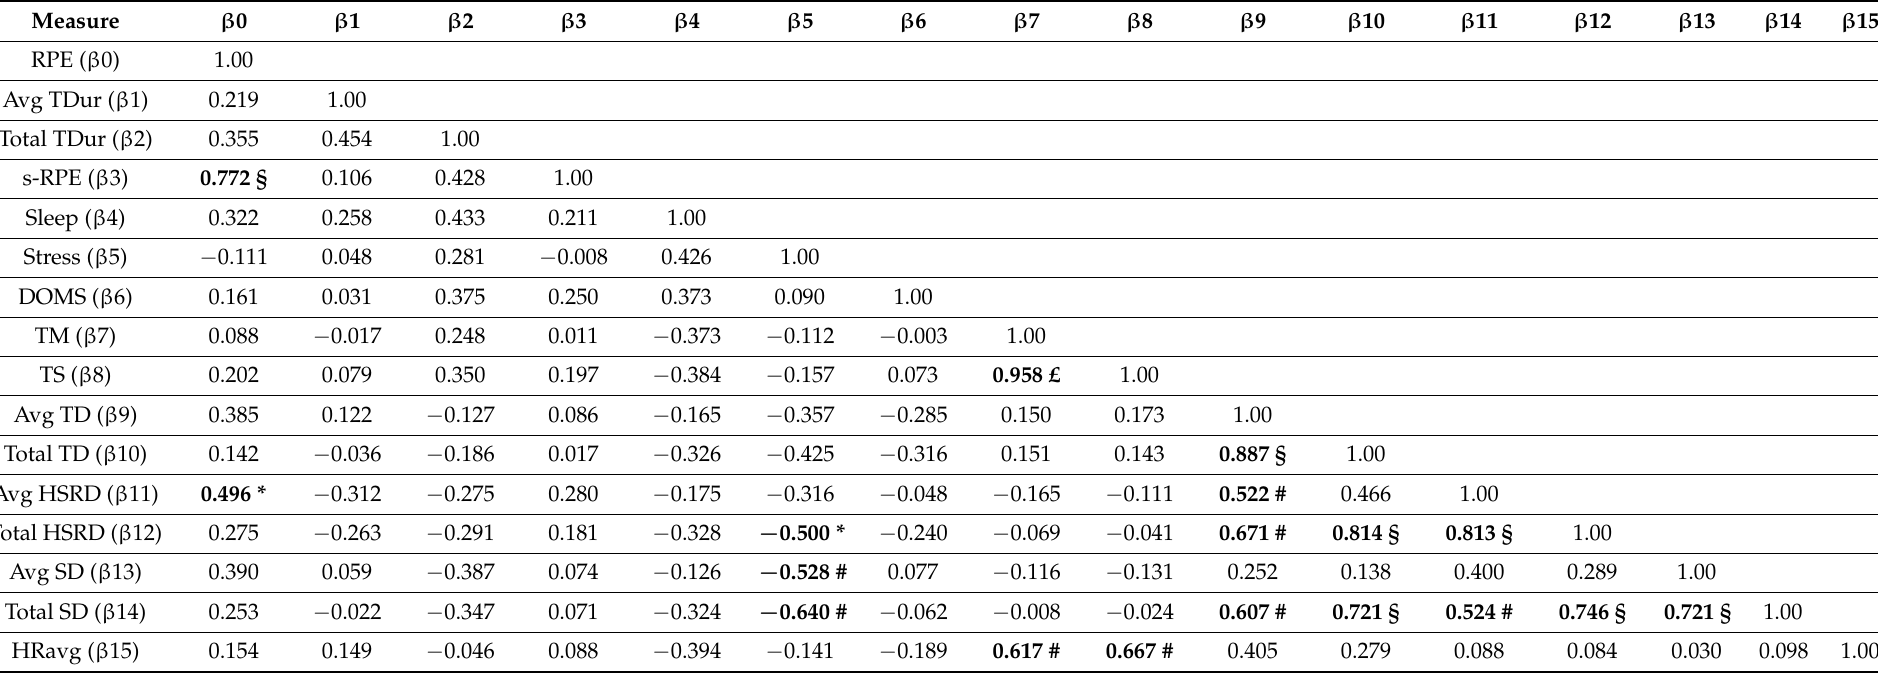
Table 5. Correlation analysis between the measures in study on the